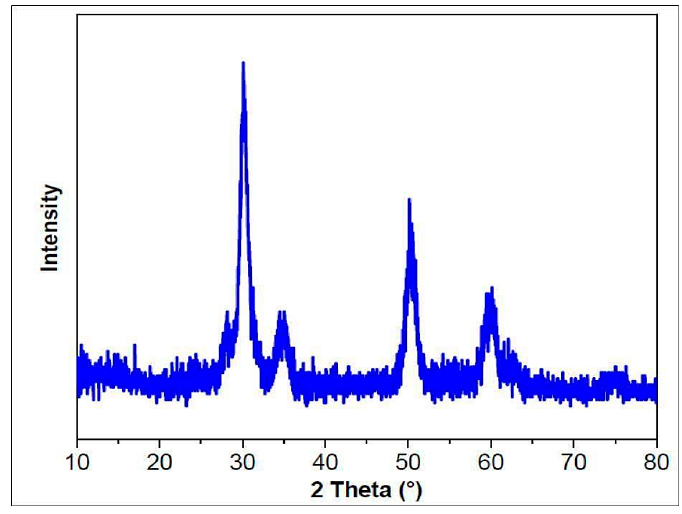
Figure 1. X-ray powder diffraction ( XRD) pattern of ZrO 2 nanoparticles (NPs).